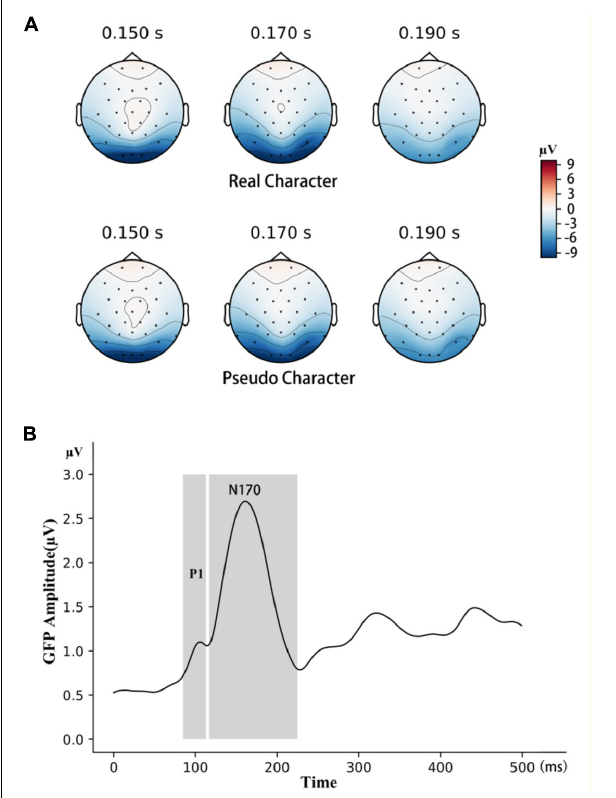
FIGURE 2 | (A) The topographic maps evoked by real and pseudo characters, 150, 170, and 190 ms following stimulus presentation. (B) The time windows for P1 and N170 was selected with the GFP method, see text for